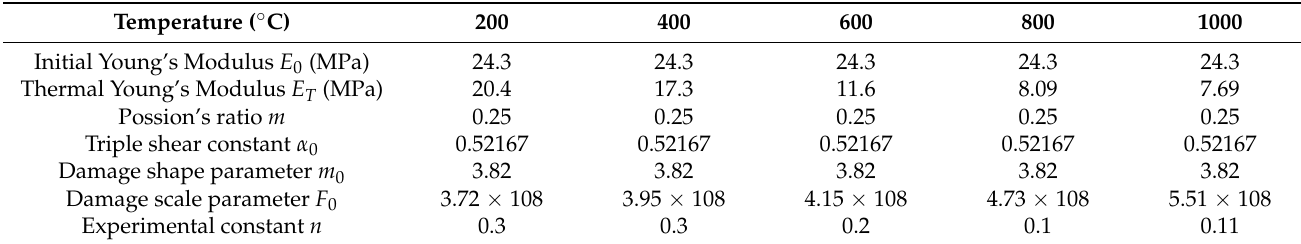
and triple-shear Drucker–Prager yield condition.